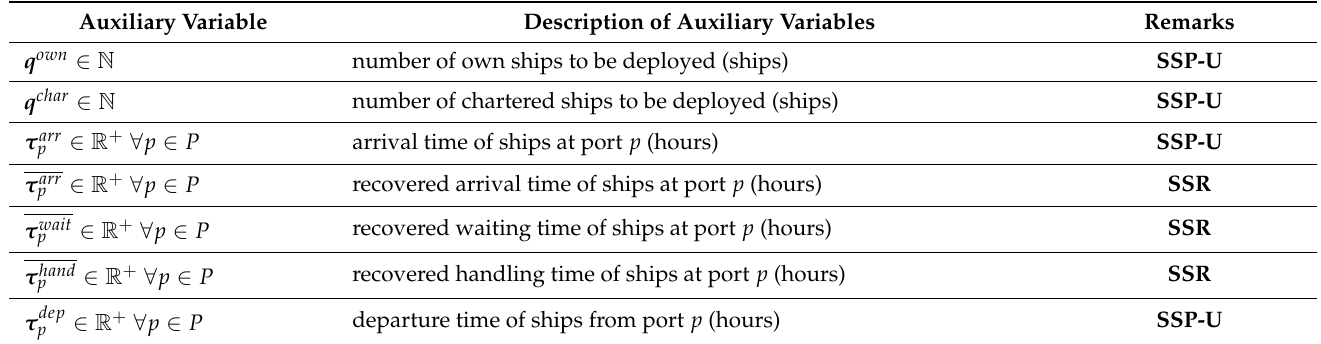
Table A3. Definition of auxiliary